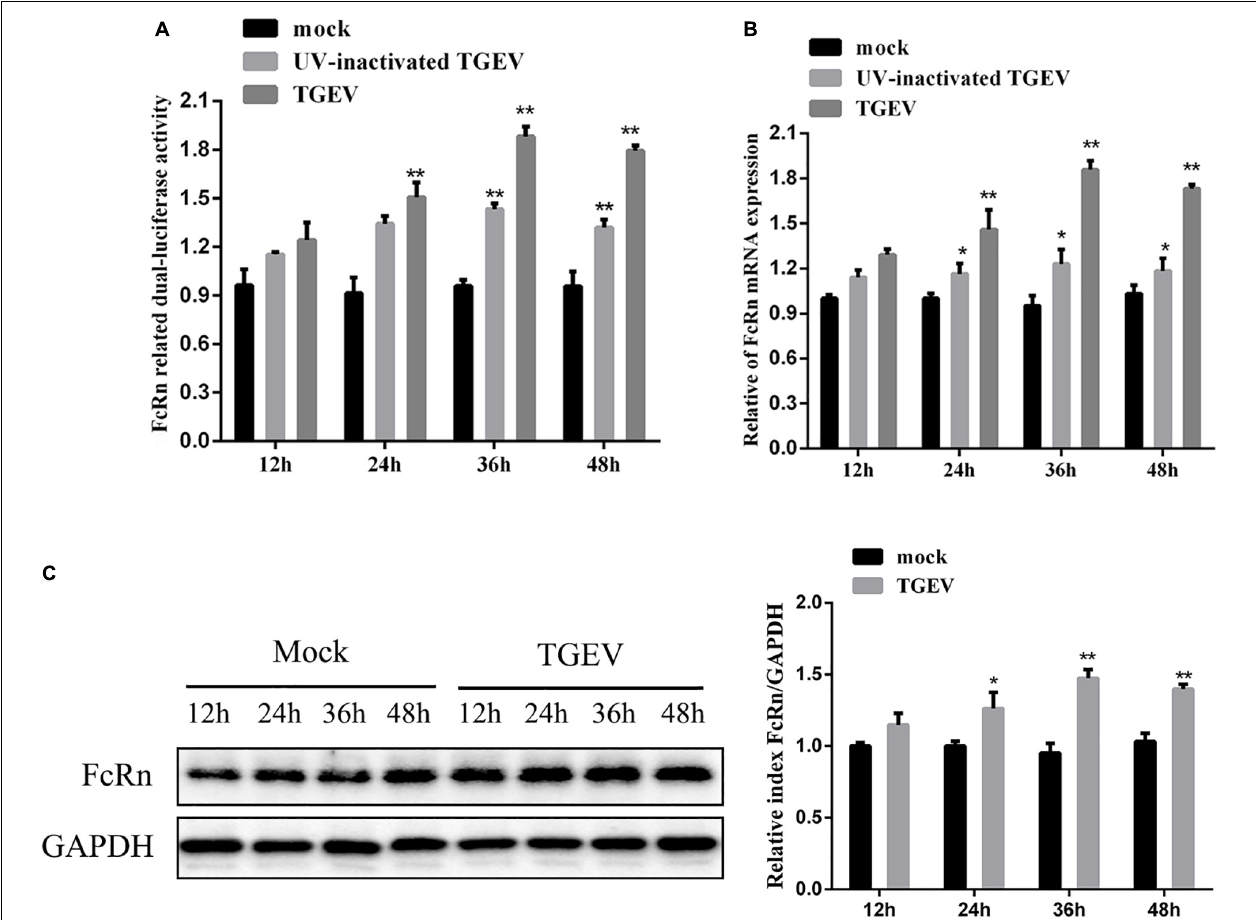
FIGURE 1 | TGEV-induced activation of FcRn depends on viral replication. (A) IPEC-J2 were co-transfected with pRL-TK and FcRn-Luc, followed by alive TGEV or UV-inactivated TGEV (MOI 1). Cells were harvested at 12, 24, 36 or 48 hpi, and the lysates were analyzed by dual-luciferase assay. (B) IPEC-J2 cells were infected with alive TGEV or UV-inactivated TGEV at a MOI of 1. Cells were harvested at 12, 24, 36 or 48 hpi, and the lysates were analyzed by RT-qPCR. (C) IPEC-J2 were infected with alive TGEV at a MOI of 1. Cells were harvested at 12, 24, 36 or 48 hpi, and the lysates were analyzed by Western blot. ∗ p < 0.05, ∗∗ p <